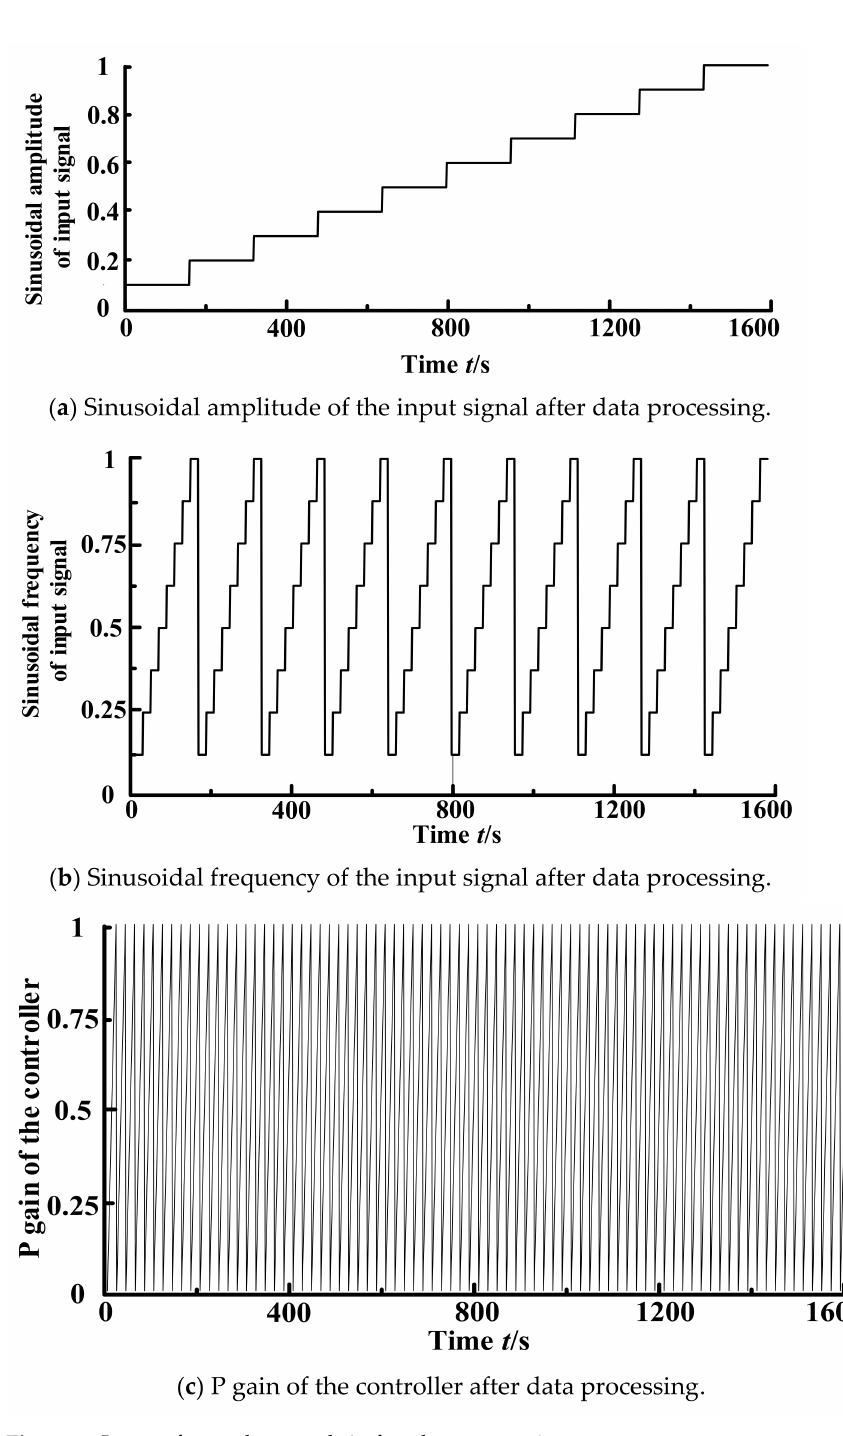
Figure 7. Input of neural network 1 after data